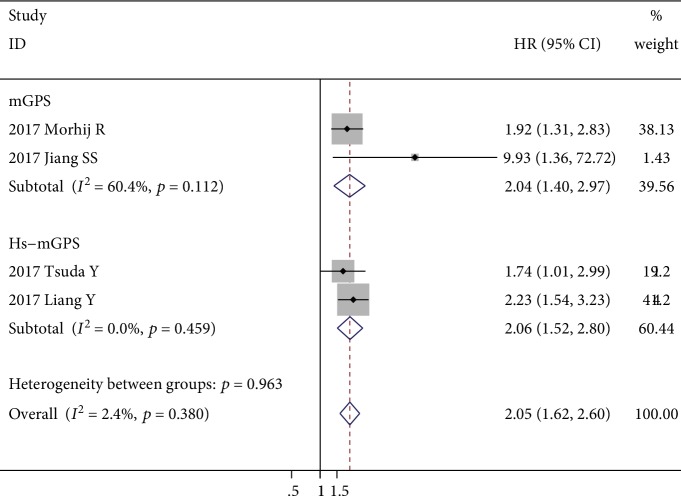
Forest plot showing the association between elevated GPS and DFS in patients with sarcoma. The pooled effect was calculated using a fixed-effects model.